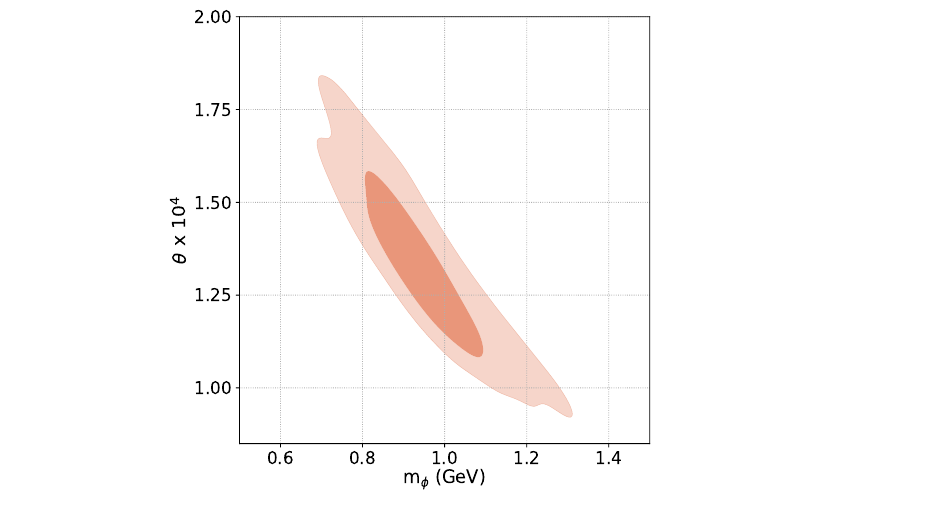
Figure 5. The marginalised joint 68% and 95% CL regions obtained for m ϕ and θ from the fit of the dark Higgs inflation model with curvature corrections with the P LANCK TT, TE, EE + lowE + lensing + BK15 dataset. Table 2. The mean values and the absolute errors of the main parameters obtained from the fit of the dark Higgs inflation model with curvature corrections with P LANCK TT, TE, EE + lowE + lensing + BK15 dataset. The errors are quoted at 68% CL. The upper limits are quoted at 95% CL. The first group of parameters are the base cosmological parameters sampled in the Monte-Carlo Markov Chains analysis with uniform priors.The others are derived